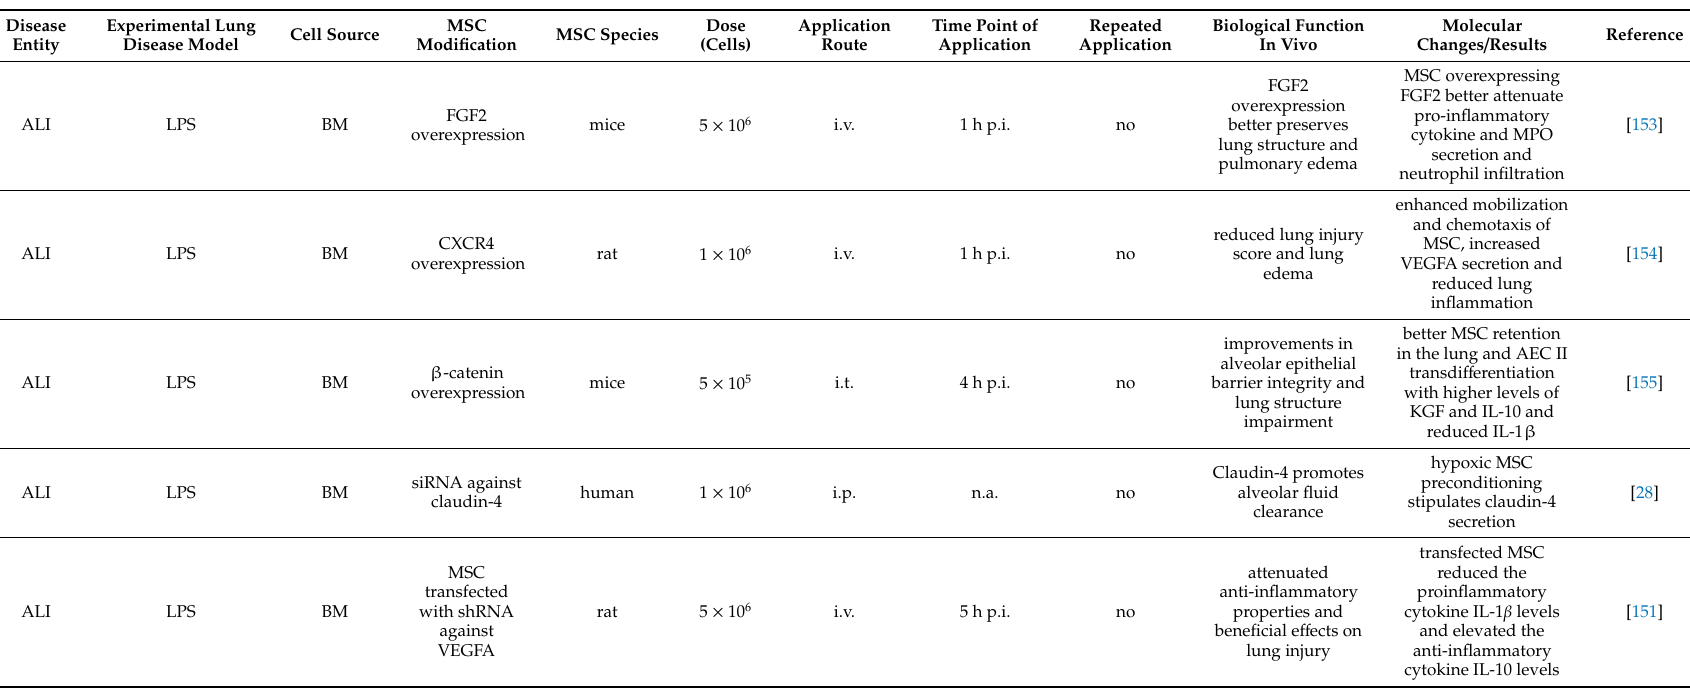
Table 6. Summary of selected preclinical studies in rodents aiming to improve the therapeutic e ffi cacy of MSC by genetic